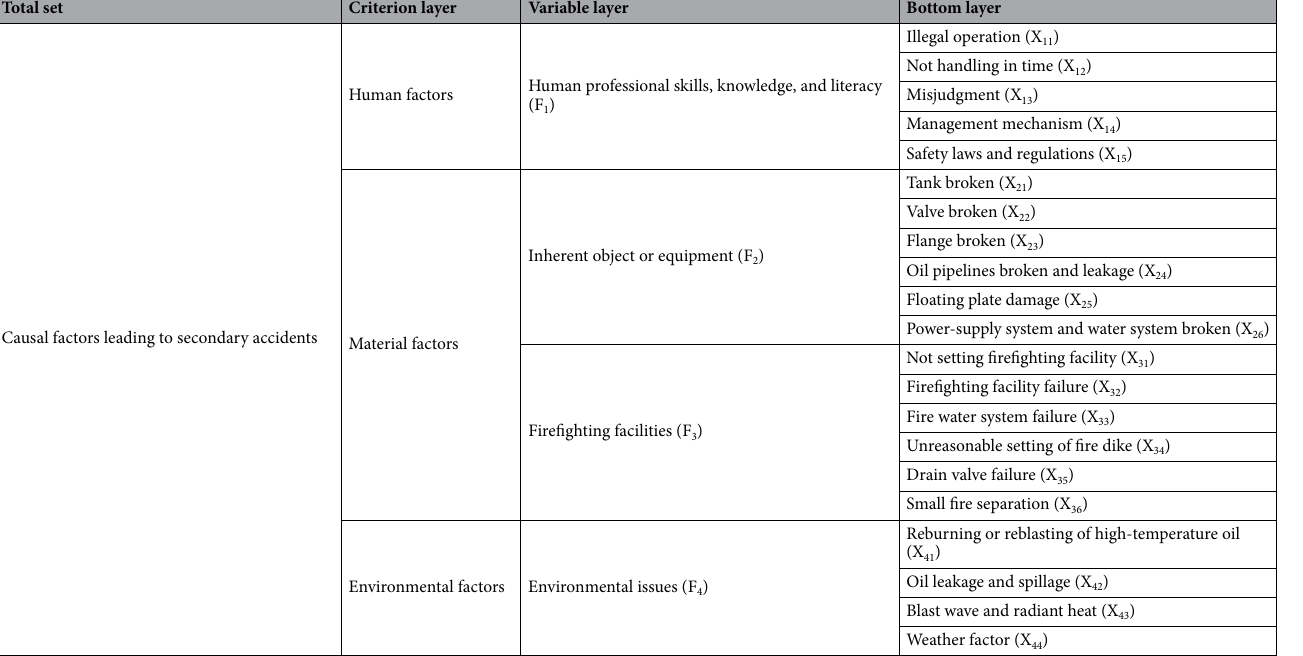
Table 2. Level decomposition table of causal factors in emergency